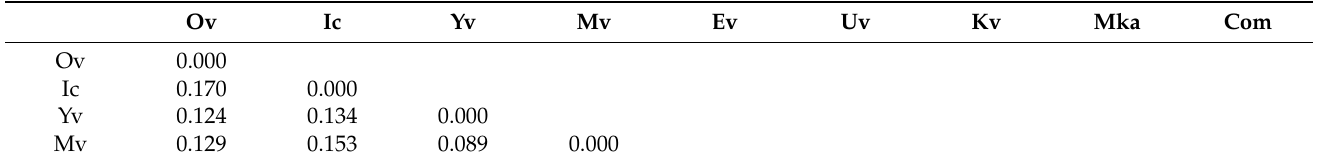
Table 8. Pairwise population matrix of Nei genetic (h) distance for nine groups of beans ( P. vulgaris L.)